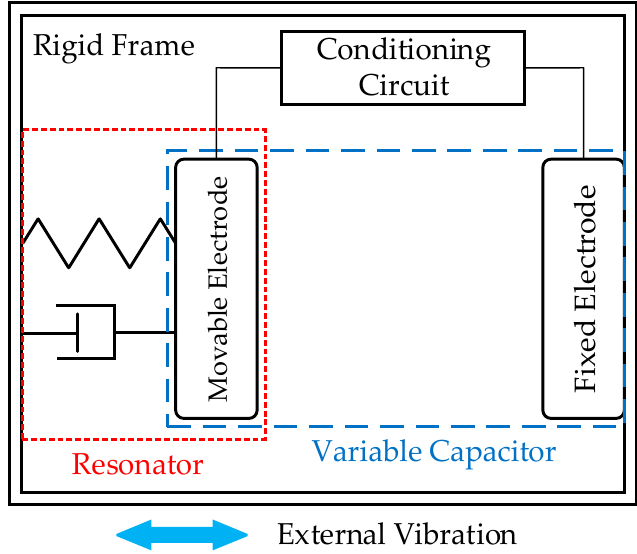
Figure 15. Schematic of an electrostatic energy harvester.